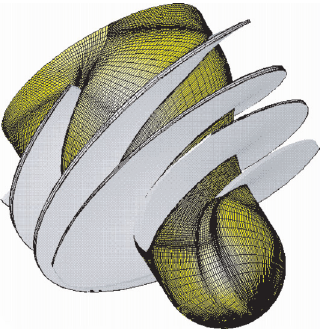
Figure 5: Total pressure increase on the hub at nominal flow rate.